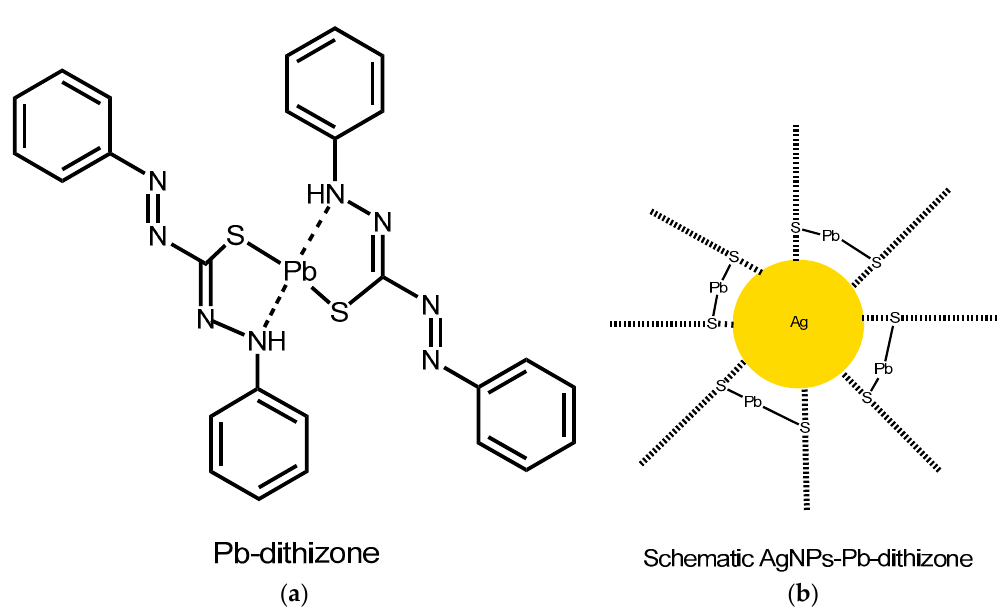
Figure 6. ( a ) Complex of Pb 2+ and dithizone; ( b ) Interaction between AgNPs and disulfide of dithizone in Pb(II)-dithizone.